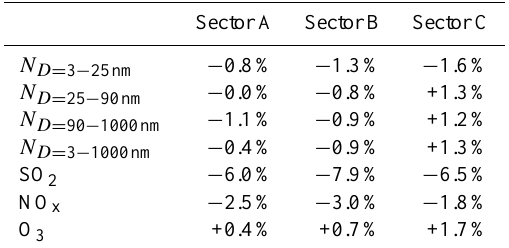
Table 2. Average yearly change in median RSC-values of atmo- spheric constituents in sectors represented in Fig. 2. Linear regres- sion line is fitted to the yearly CFs between years 1996–2008.